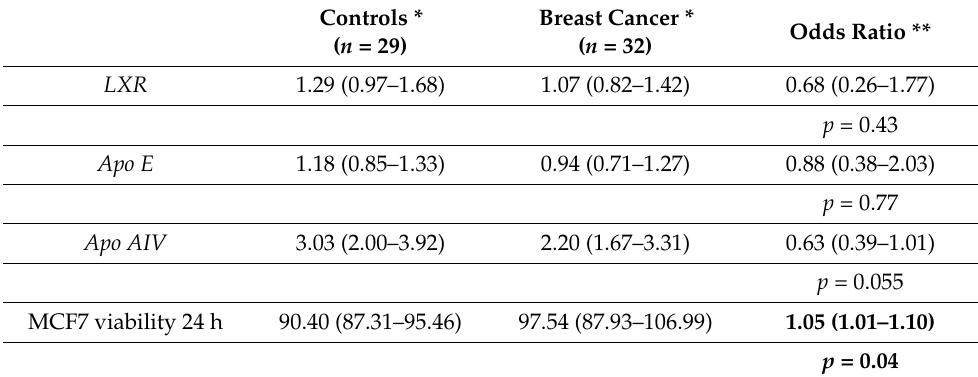
Table 3. MCF-7 cell viability after incubation with the basolateral medium of Caco-2 cells exposed to fecal waters from patients and controls and lipid metabolism gene expression in the intestine